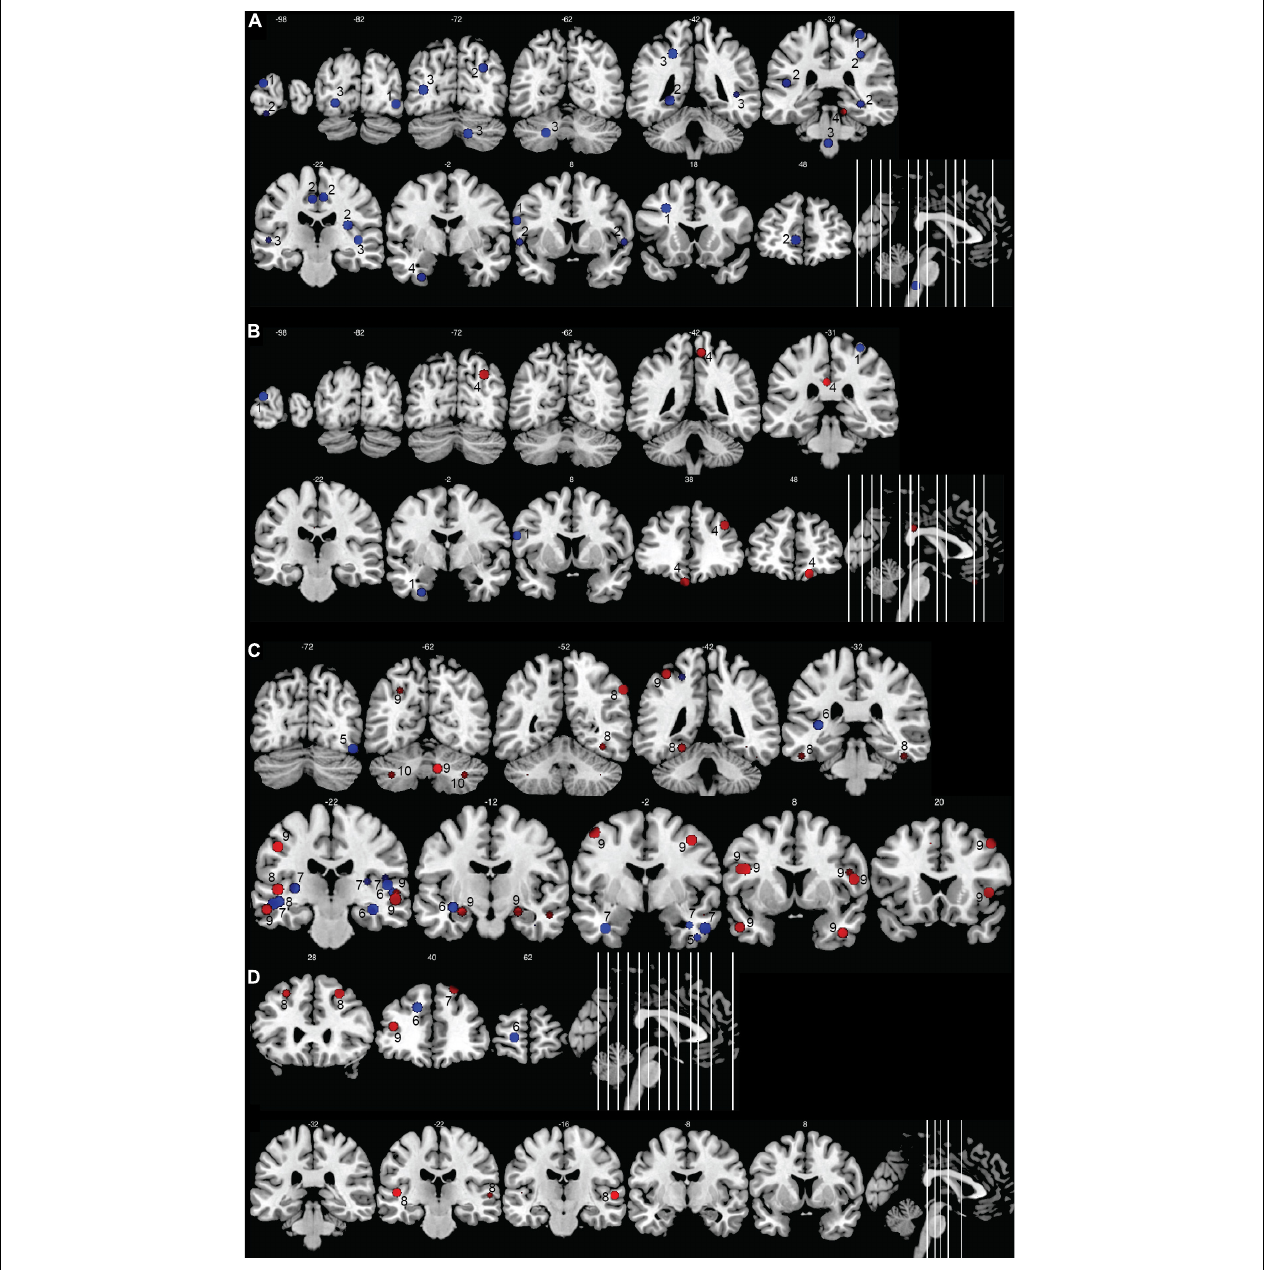
FIGURE 5 | Morphometric changes in the human deaf brain. Increases in GM or WM volume in the deaf compared to hearing controls are shown in red, decreases in blue. (A) GM and WM volume in deaf children; (B) cortical thickness in deaf children; (C) GM and WM volume in deaf adults; (D) cortical thickness in deaf adults. The image shows the peak (or center) of the areas with modifications in volume or cortical thickness; cluster volumes are not indicated. Some spheres appear smaller because they are shown on slices which are not positioned at the center of the spheres. Right hemisphere is shown on the right of the images. The numbers on top of the slices show the y -coordinates of the coronal slices in MNI space. The numbers inside the slices correspond to the studies from which the coordinates are taken. 1: Li J. et al. (2012); 2: Feng et al. (2018); 3: Smith et al. (2011); 4: Li et al. (2013); 5: Qi et al. (2019); 6: Kim et al. (2009); 7: Olulade et al. (2014); 8: Kumar and Mishra (2018); 9: Leporé et al. (2010a); 10: Hribar et al.